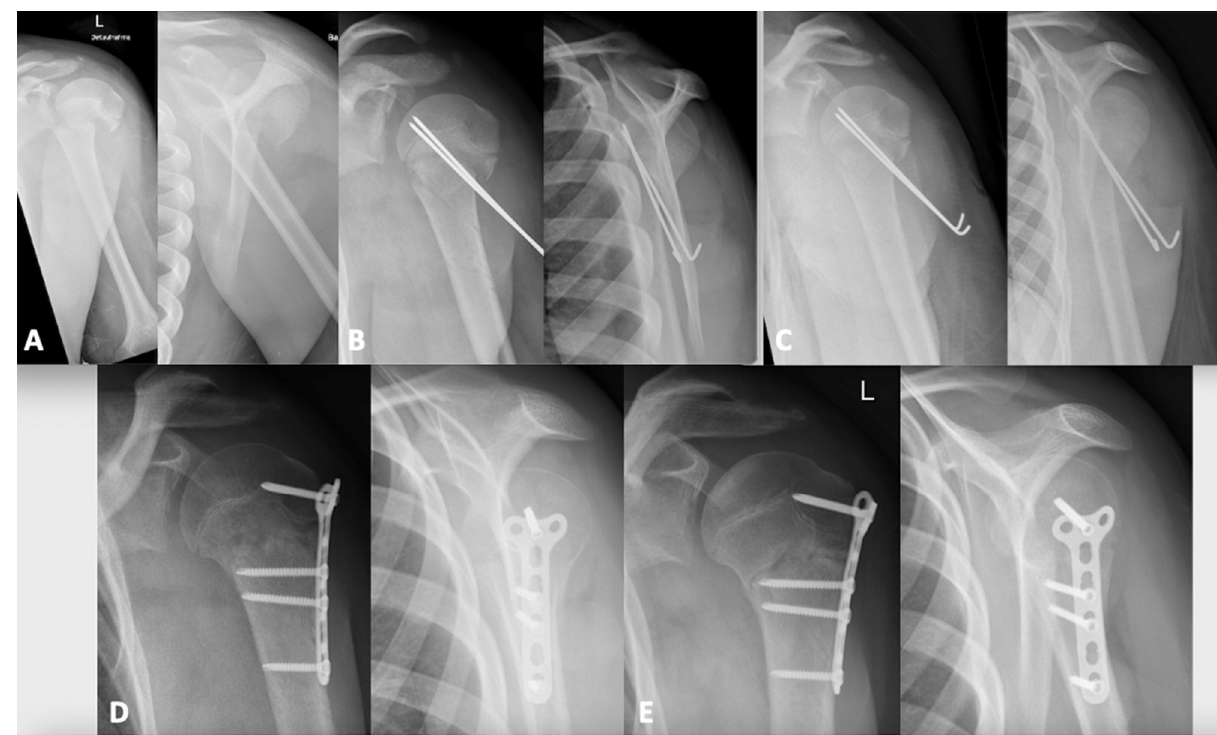
Figure 2. Chronologic radiographic images of Pat. N° 1. ( A ) Initial images after trauma with a posteriorly displaced prox- imal humeral fracture. ( B ) After closed reduction and transepiphyseal fixation. ( C ) X-ray 1 day after surgery shows pos- terior displacement in the Neer view (right side). ( D ) Open reduction and T-plate fixation. ( E ) X-ray follow-up 10 weeks after open reduction and plate-fixation with anatomical reduction and fracture healing.